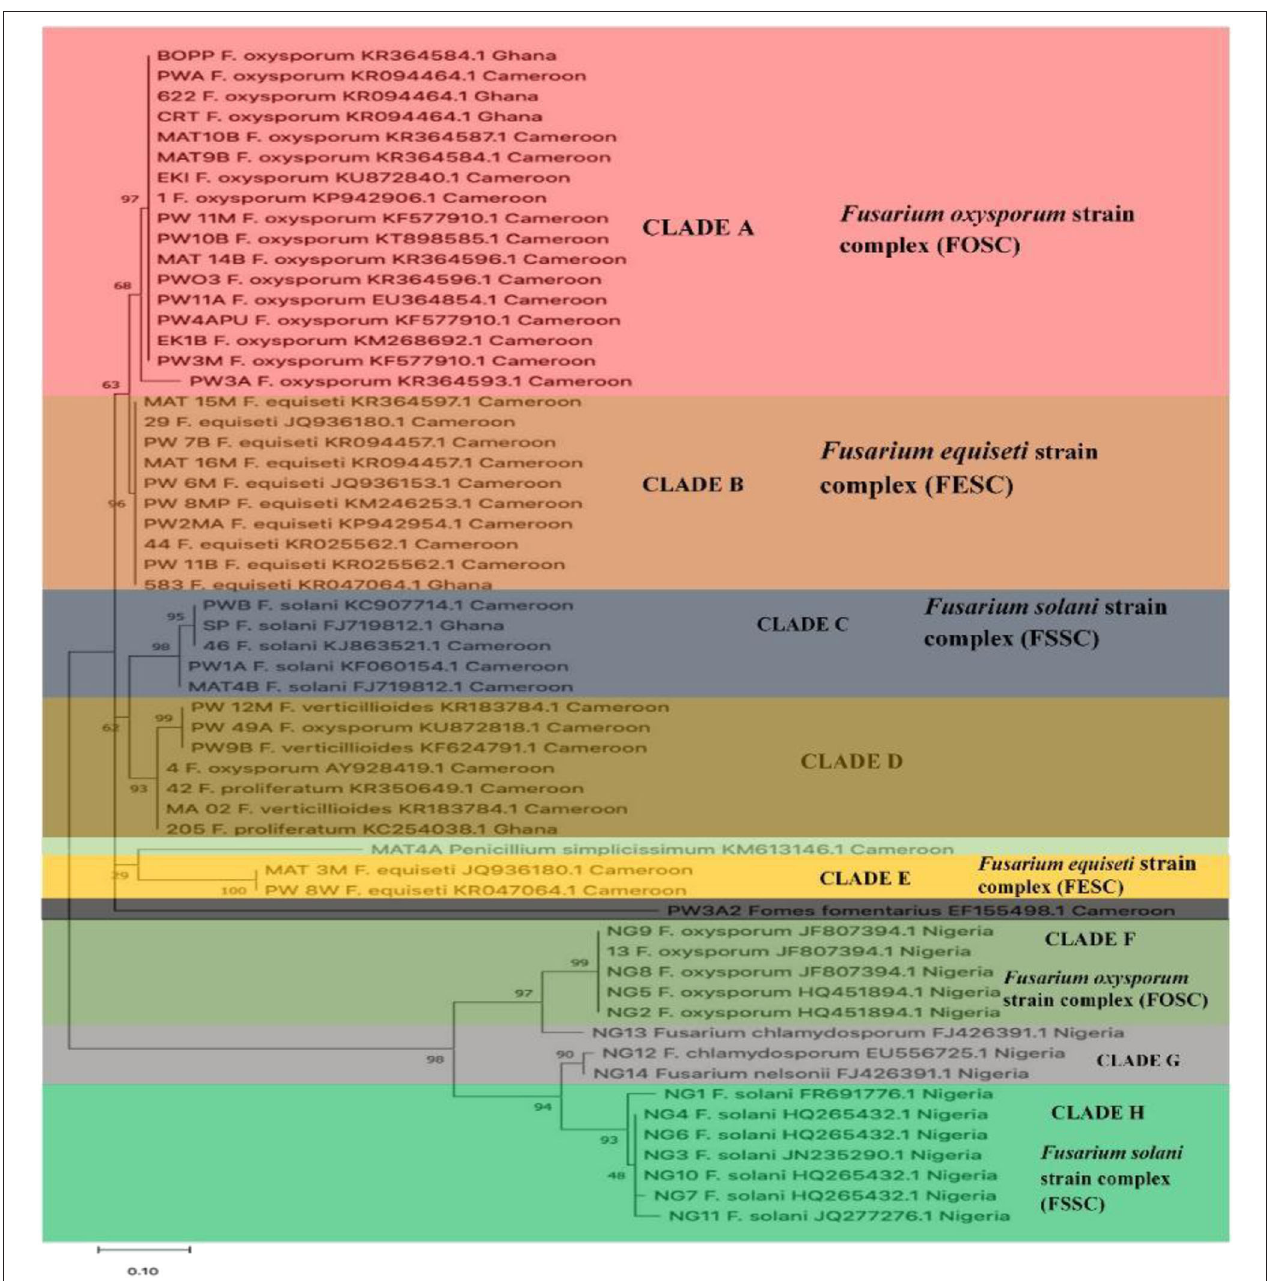
FIGURE 3 | The phylogenetic tree of Fusarium strains and secondary pathogens using Neighbor- Joining method.